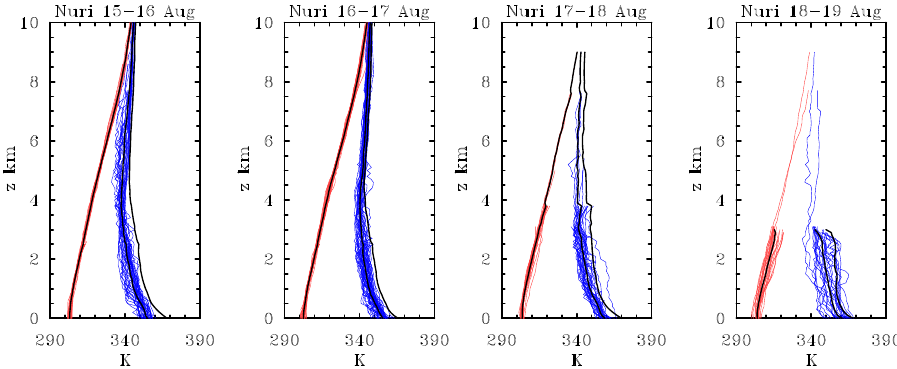
Fig. 3. Vertical profiles of the virtual potential temperature ( θ v ) and pseudo-equivalent potential temperature ( θ e ) from each usable sounding on all days of Nuri. Plotted also is the mean profile on each day of measurement (solid black curves) and the saturation pseudo-equivalent potential temperature ( θ es ) based on this mean sounding (far right solid black curve). The mean sounding for the last day of observations is plotted only up to 3 km height since the two soundings that extend to higher levels are located outside of the storm. See text for further details.